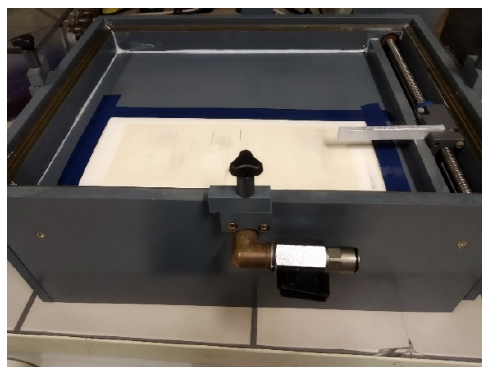
Figure 1. Photo of the DCSBD plasma reactor.